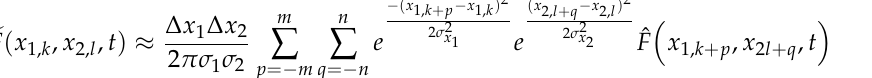
Figure 6. C-Scan of sample B2 after applying a gaussian filter. Color indicates the normalized am- plitude of the ultrasonic data. Proper smoothing of the data helps to improve the boundaries around the foreign object, but the resolution of the edges of the foreign objects is limited by the resolution of the scan data. The time cost of scanning with a finer resolution, as well as the increased computation costs from the larger data set, make finer scanning resolutions impractical in many cases. Interpolation of the data can be used to solve this issue in the c-scan data. It was determined that interpolating the data after applying the MGA method was prefera- ble and less computationally expensive. It is also important to first smooth the data to prevent the interpolation from propagating numerical noise in the interpolation functions. The process proposed by the authors is to first interpolate 𝐹̃(𝑥 1,𝑘 , 𝑥 2,𝑙 ) along 𝑥 1 using a Fourier transform interpolation to an intermediate dataset 𝐻 ′ (𝑥 1,𝑖 , 𝑥 2,𝑙 ) and then use the Fourier transform to interpolate along 𝑥 2 to an upsampled dataset 𝐻(𝑥 1,𝑖 , 𝑥 2,𝑗 ) . The new upsampled data set uses the indices 𝑖 and 𝑗 to replace 𝑘 and 𝑙 , as described in Equa- tions Equation (6) and Equation (7). In the present study, the sampling density was in- creased fivefold in both dimensions for visual purposes. Thus, the indices and data points become: 𝑖 = 1,2, … 5𝑁 𝑘 ; 𝑥 1,1 = 0 ; 𝑥 1,5𝑁 𝑘 = max (𝑥 1 ) (6) 𝑗 = 1, 2, … 5𝑁 𝑙 ; 𝑥 2,1 = 0 ; 𝑥 2,5𝑁 𝑙 = max (𝑥 2 )